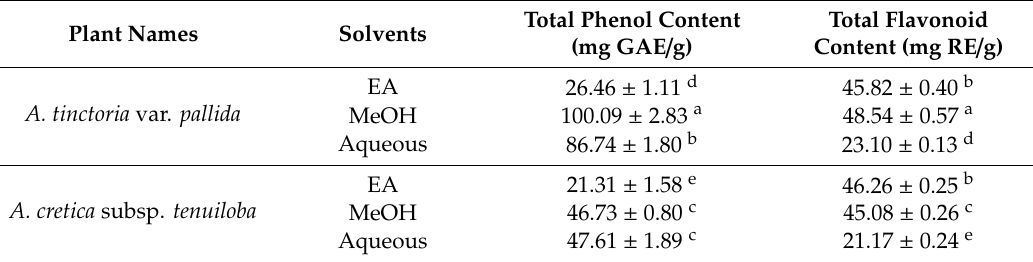
Table 1. Total phenol and flavonoid content of Anthemis extracts